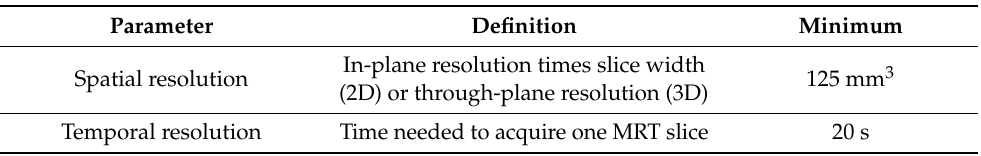
Table 1. Minimum acquisition parameters, such that successful MRT in hyperthermia can be achieved.